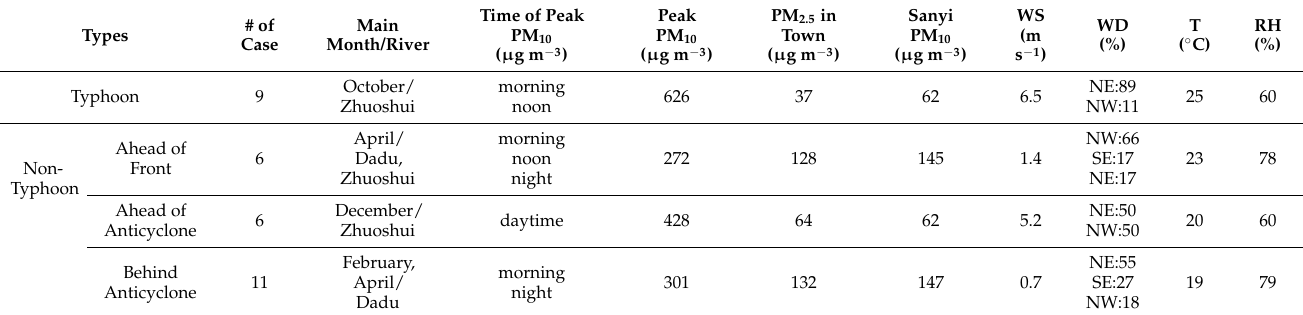
Table 2. Summary of the aerosol and weather conditions for riverbed events in Table 1, including number of cases, main month and river of the weather type, time of peak concentration, mean peak PM 10 concentrations, and mean PM 2.5 concentrations in town, mean peak PM 10 concentrations in Sanyi background station, mean wind speed (WS), percentage of wind direction (WD), mean temperature (T), and mean relative humidity (RH) at peak PM 10